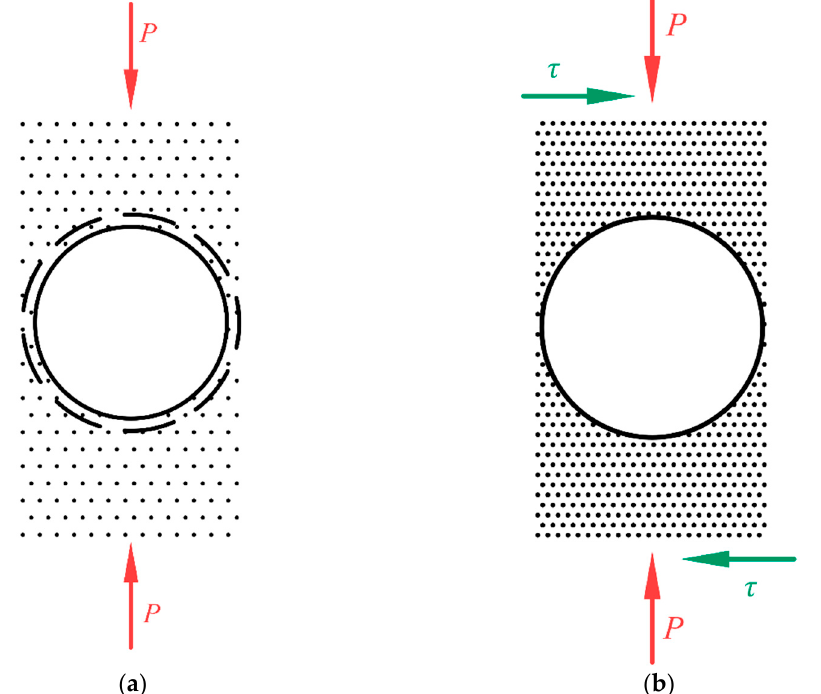
Figure 2. Diagram of acting forces at the pore during powder preforming in the die: ( a ) standard scheme—cracks appearing in the powder preform around a pore; ( b ) proposed scheme—one of the pores in the process of closing during the simultaneous application of compressive stress P and shear stress τ .